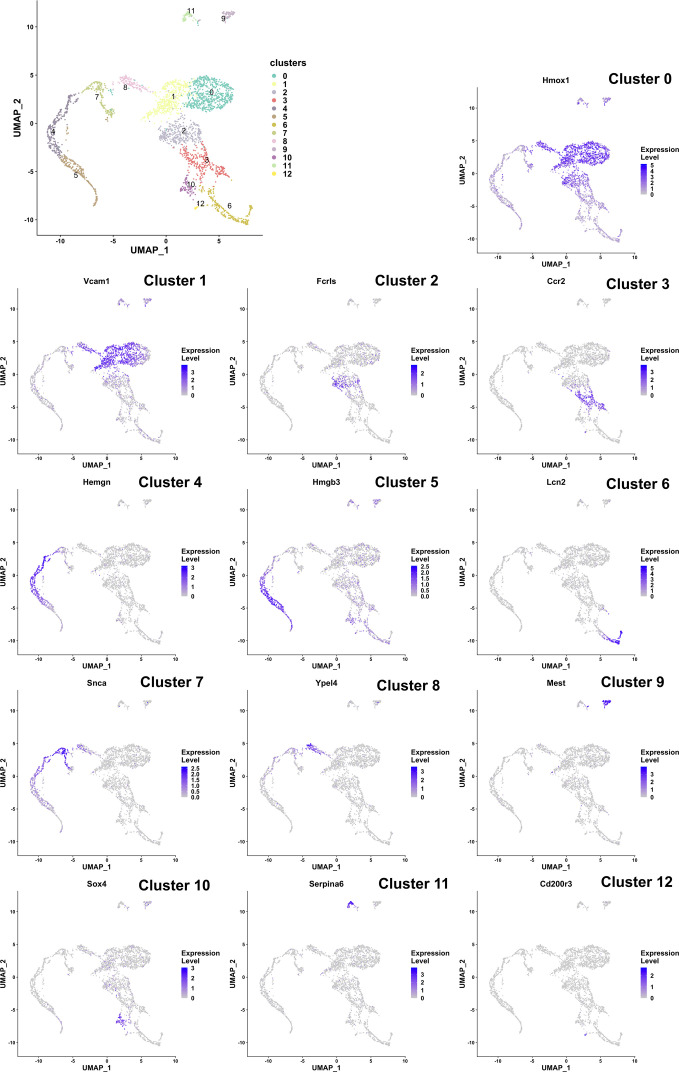
Markers for each gene expression-based cluster of cells identified from single-cell sequencing of F4/80+ fetal liver macrophages.Cluster number and marker names are indicated.